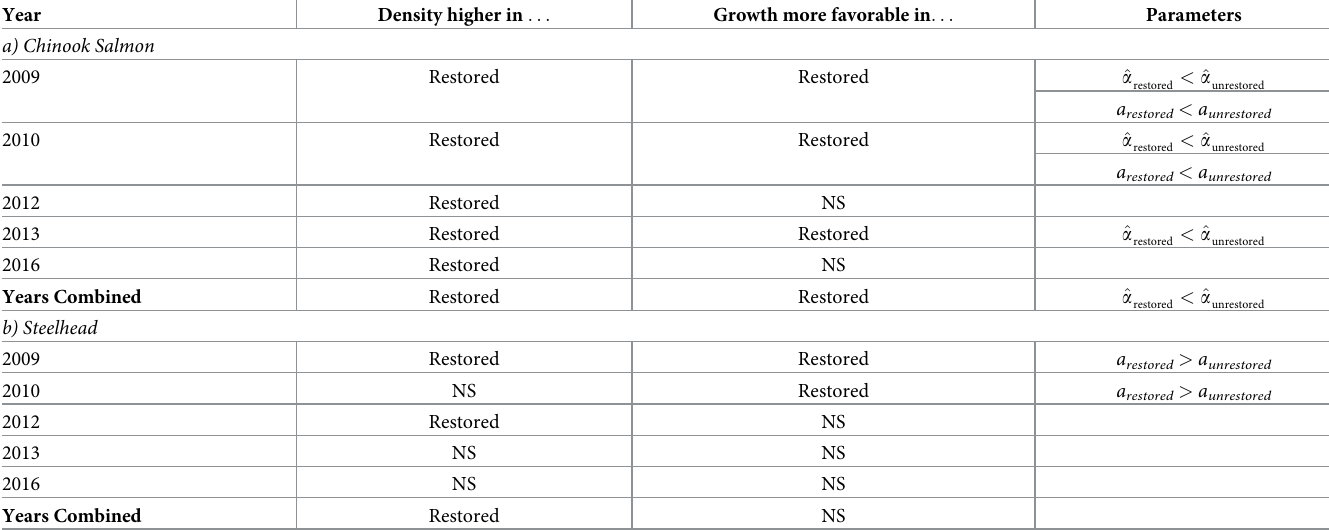
Table 1. Concordance of occupancy differences and growth-parameter differences. Recall that large ^ a means that the inflection point comes later in the season, indicat- ing less favorable growth conditions (NS = No difference/not significant). Year Density higher in ... Growth more favorable in